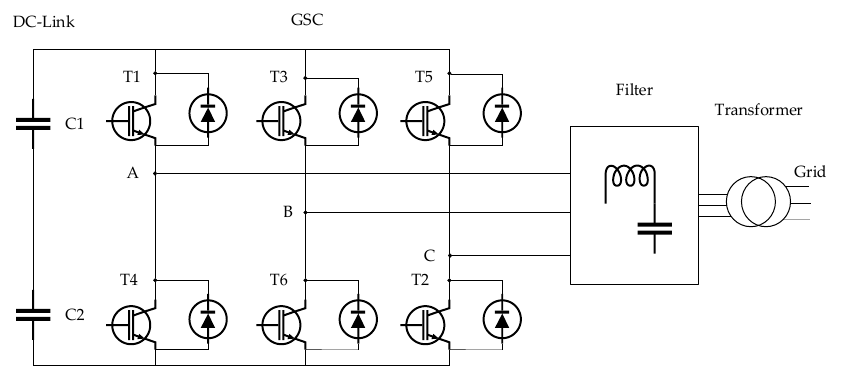
Figure 1. The topological graph of the grid-side converter (GSC).